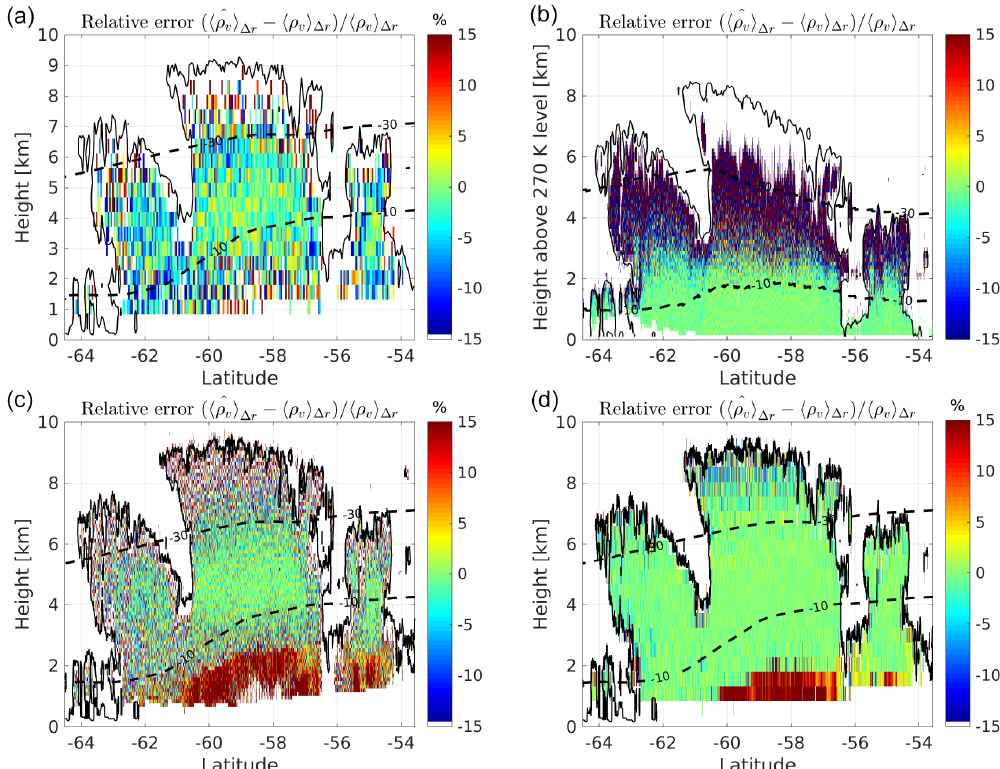
Figure 6. (a) Relative error in the retrieval of ρ v for the case study shown in Fig. 3 for a seven-channel space-borne DAR with frequencies as listed in the legend in Fig. 5a. Here (cid:49)r = 480m and a 5km along-track averaging has been performed. The dashed lines correspond to the − 30 and − 10 ◦ C isotherms and the black line corresponds to CloudSat reflectivities of − 25dBZ (roughly indicating the cloud boundaries). (b) Same as (a) for a five-tone ground-based DAR with frequencies as listed in the legend on the bottom side of Fig. 5. Here (cid:49)r = 120m and a 2min averaging has been performed. (c, d) Same as (a) for an airborne system with (cid:49)r = 120m (c) and (cid:49)r = 480m (d) and a 1km along-track averaging. The single pulse sensitivity is assumed to be − 33dBZ (c) and − 45dBZ (d) at 1km